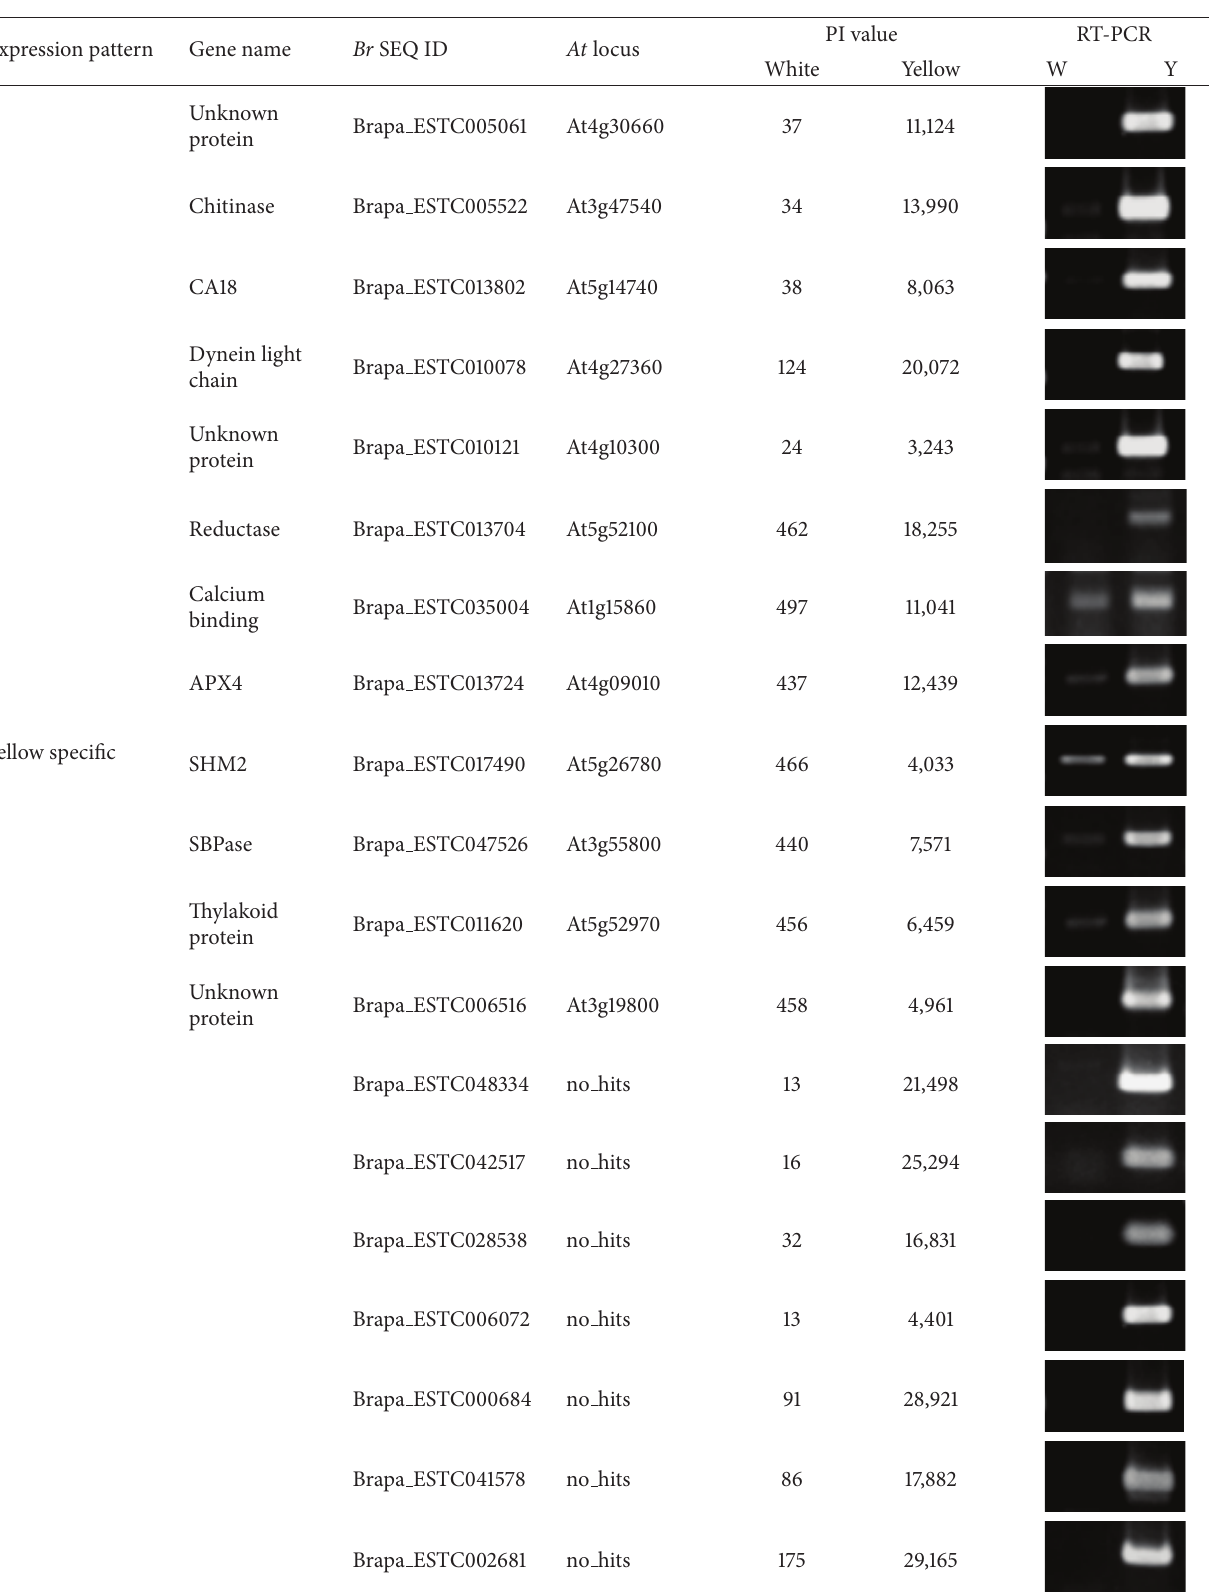
Table 3: Genes expressed specifically in either yellow or white inner